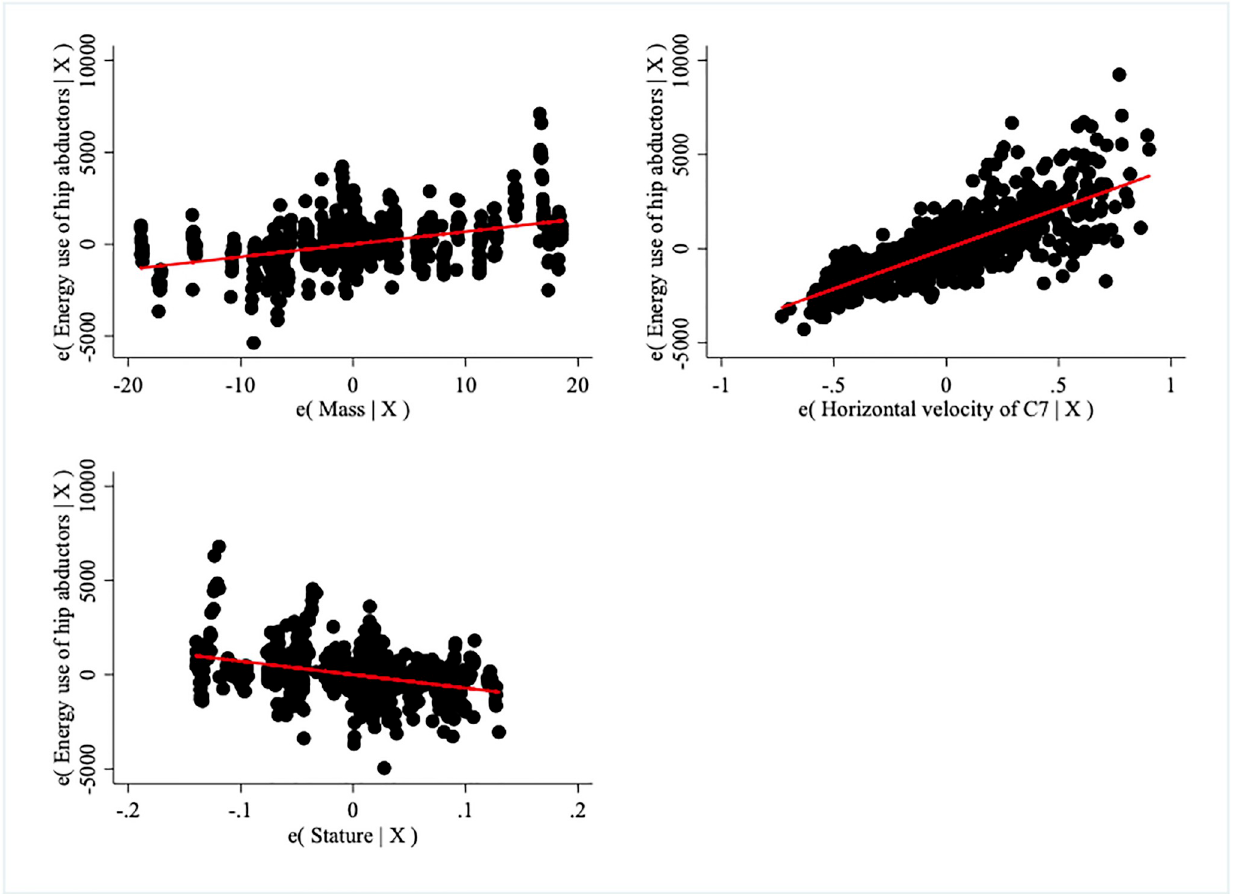
Fig 4. Contribution of mass, horizontal velocity of C7, and stature to the prediction of muscle metabolic energy expenditure of the hip abductors in a stride when the effect of other variables is controlled. Sometimes called added variable or partial regression (leverage) plots, each panel demonstrates the effect of one independent variable (either mass, velocity, or stature) on the dependent variable when the effects of the other two independent variables are accounted